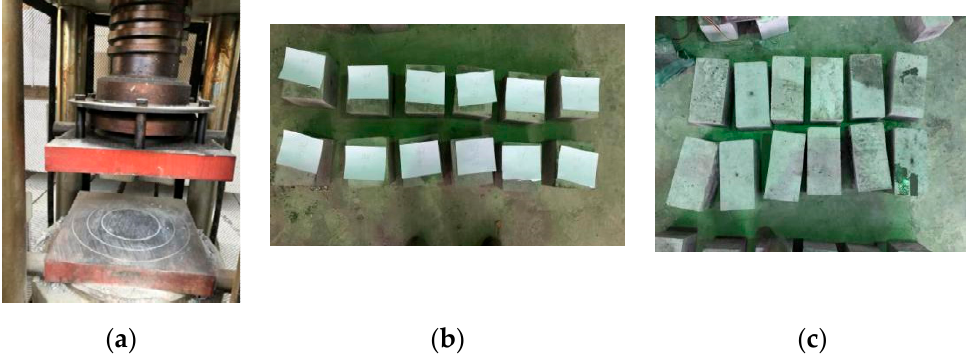
Figure 1. Loading instruments and test blocks. ( a ) Test apparatus; ( b ) test cube; ( c ) prism test block.